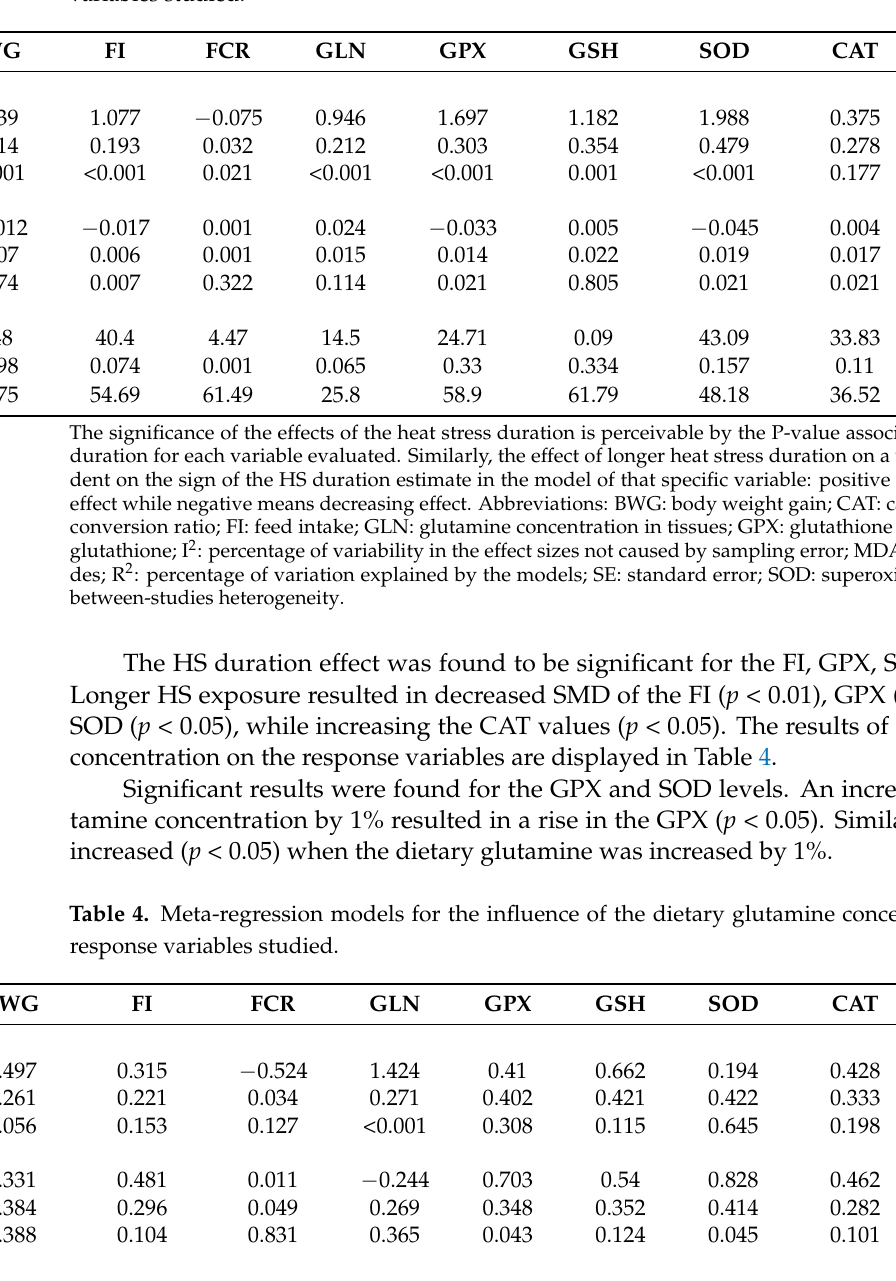
Table 3. Meta-regression models for the influence of the heat stress duration on the response variables studied.